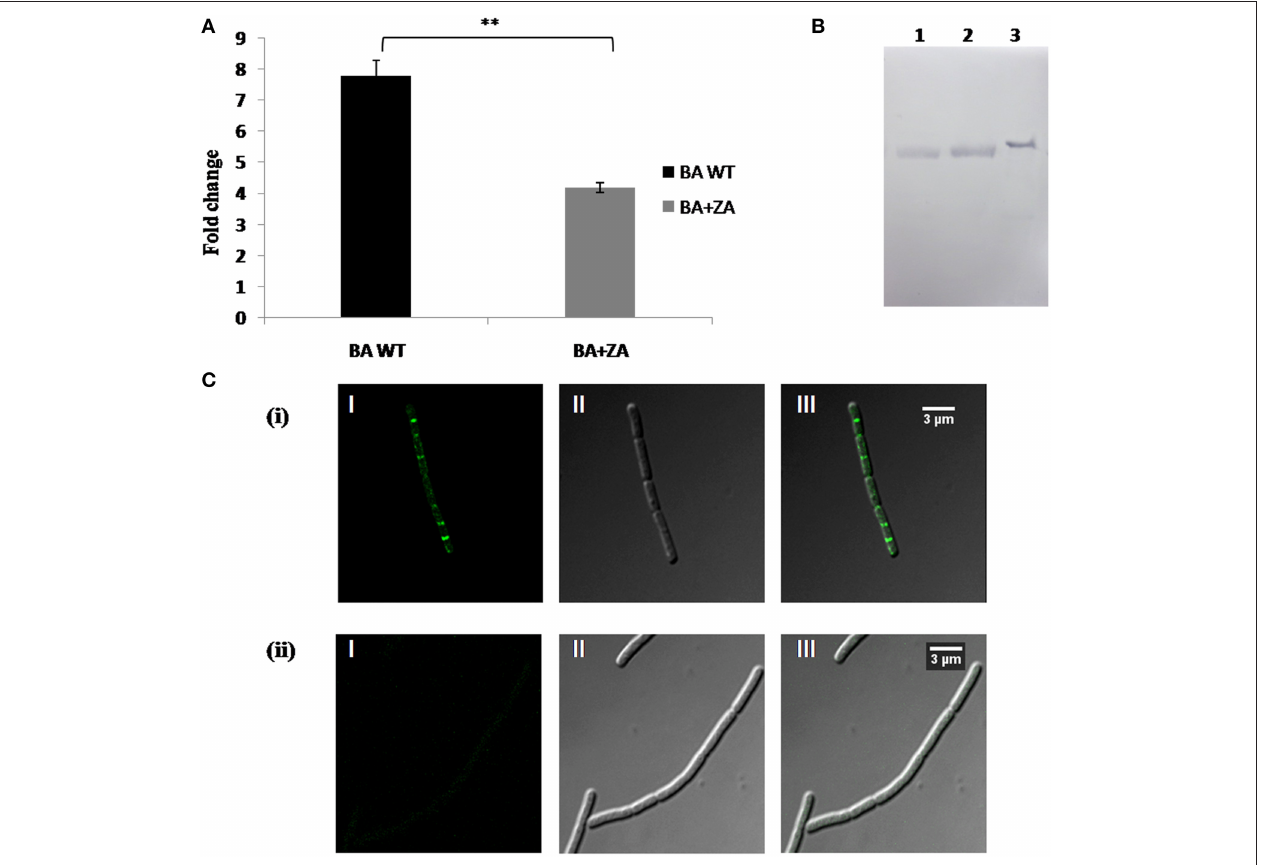
FIGURE 12 | Effect of ZA on FlotP expression in vivo. (A) Data represents the fold change in flotP expression at mRNA level by qRT–PCR taking dna gyrase as a constitutively expressed gene for normalization of C T values. The experiment was repeated two times biologically with three technical replicates. Data shown here is mean ± SME of one of the two independent biological experiment. ** indicates p ≤ 0.01 . (B) Expression analysis of FlotP at protein level by immunoblotting. Lanes: 1, Total cell lysate of ZA treated B. anthracis cells; 2, total cell lysate of ZA untreated cells; 3, purified rFlotP. (C) Immunofluorescence analysis of FlotP localization on B. anthracis cell surface using confocal microscopy; BA WT (i) , BA+ZA (ii) . In each figure, panels I, II, and III represents FITC channel, DIC channel, and superimposition of panels I and II,